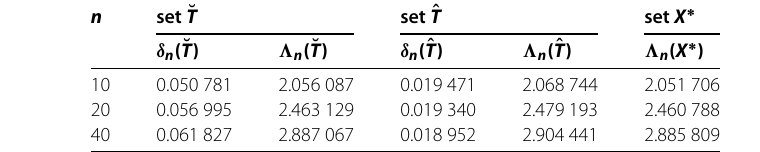
Table 1 The values of the maximum deviations and Lebesgue constants for sets ˘ T , ˆ T , and X ∗